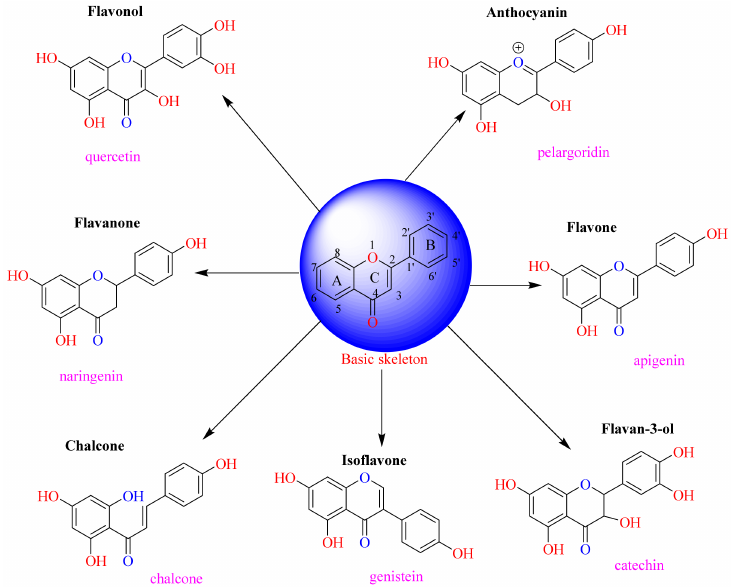
Figure 2. Representative structures of major classes of